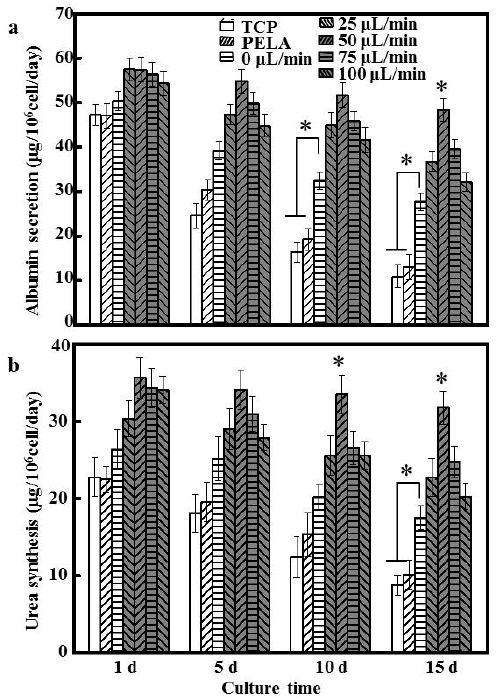
Figure 4. ( a ) Albumin secretion; ( b ) urea synthesis of hepatocytes cultured under different flow rates and substrata over 15 days ( n = 5, * p < 0.05).